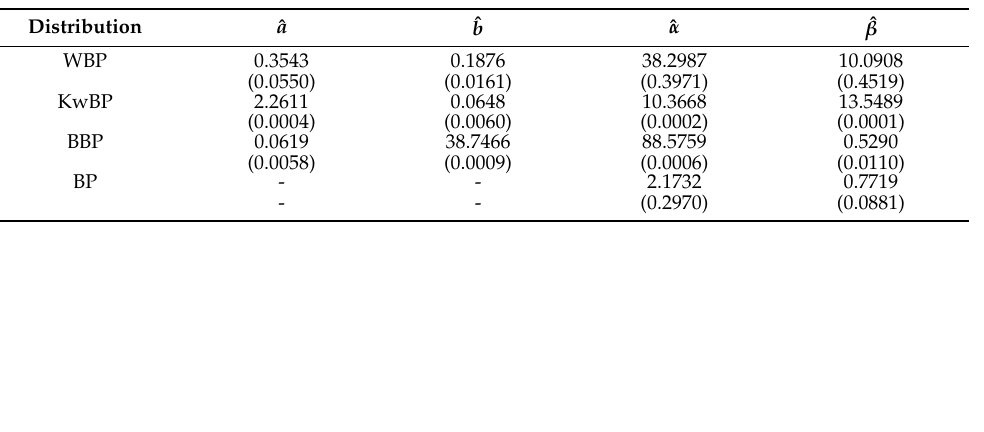
Table 5. Findings for COVID-19 data in